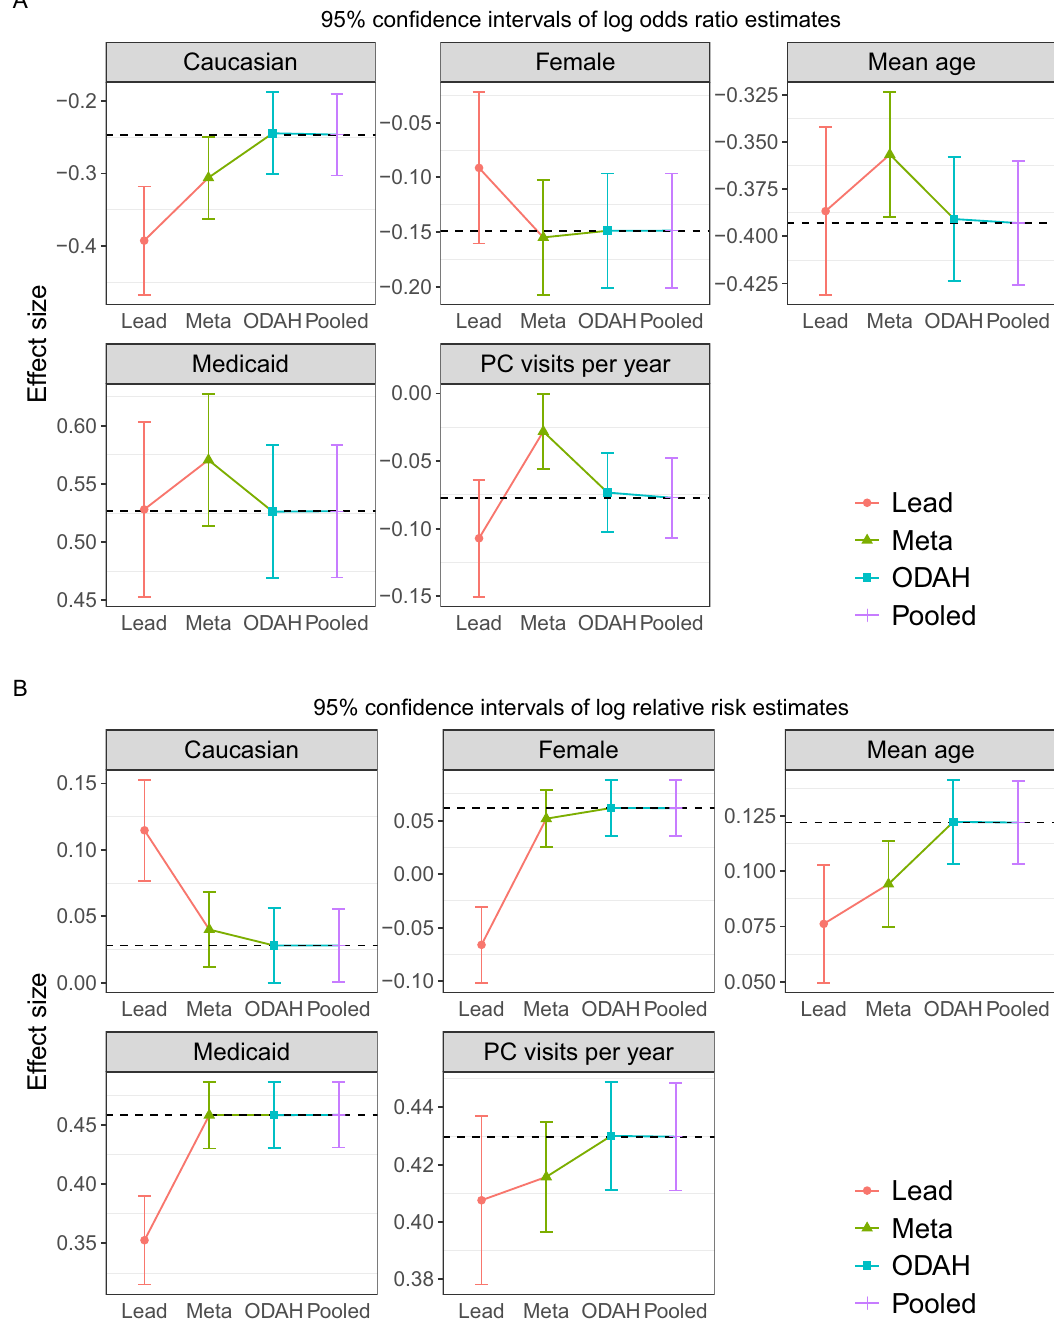
Figure 6. Plots depicting results from CHOP avoidable hospitalization analysis. Log odds ratio ( A ) and log relative risk ( B ) estimates (along with corresponding 95% confidence intervals) for each covariate in the fitted hurdle model. Dashed horizontal line represents pooled estimate, our gold standard for comparing